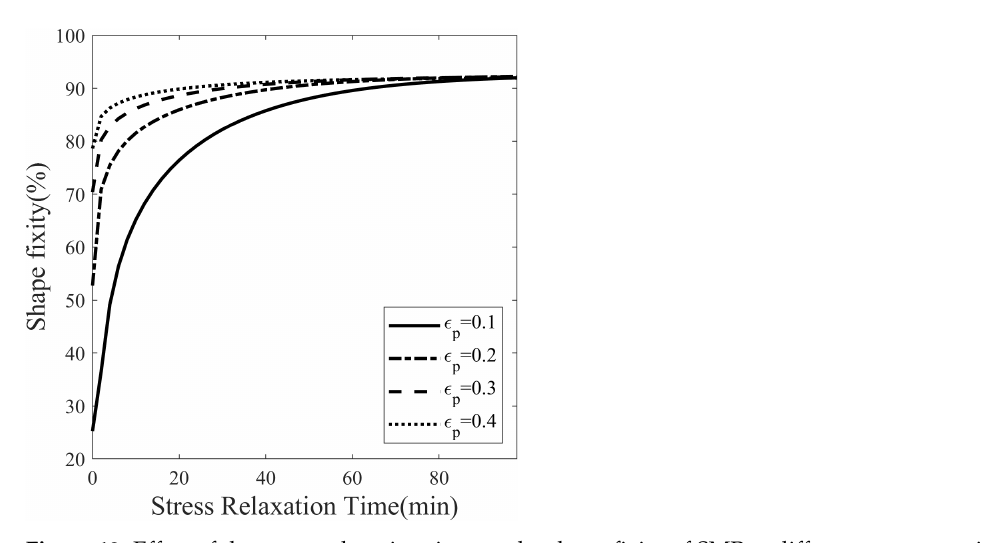
Figure 19. Effect of the stress relaxation time on the shape fixity of SMP at different programming strains ( (cid:101) p ).